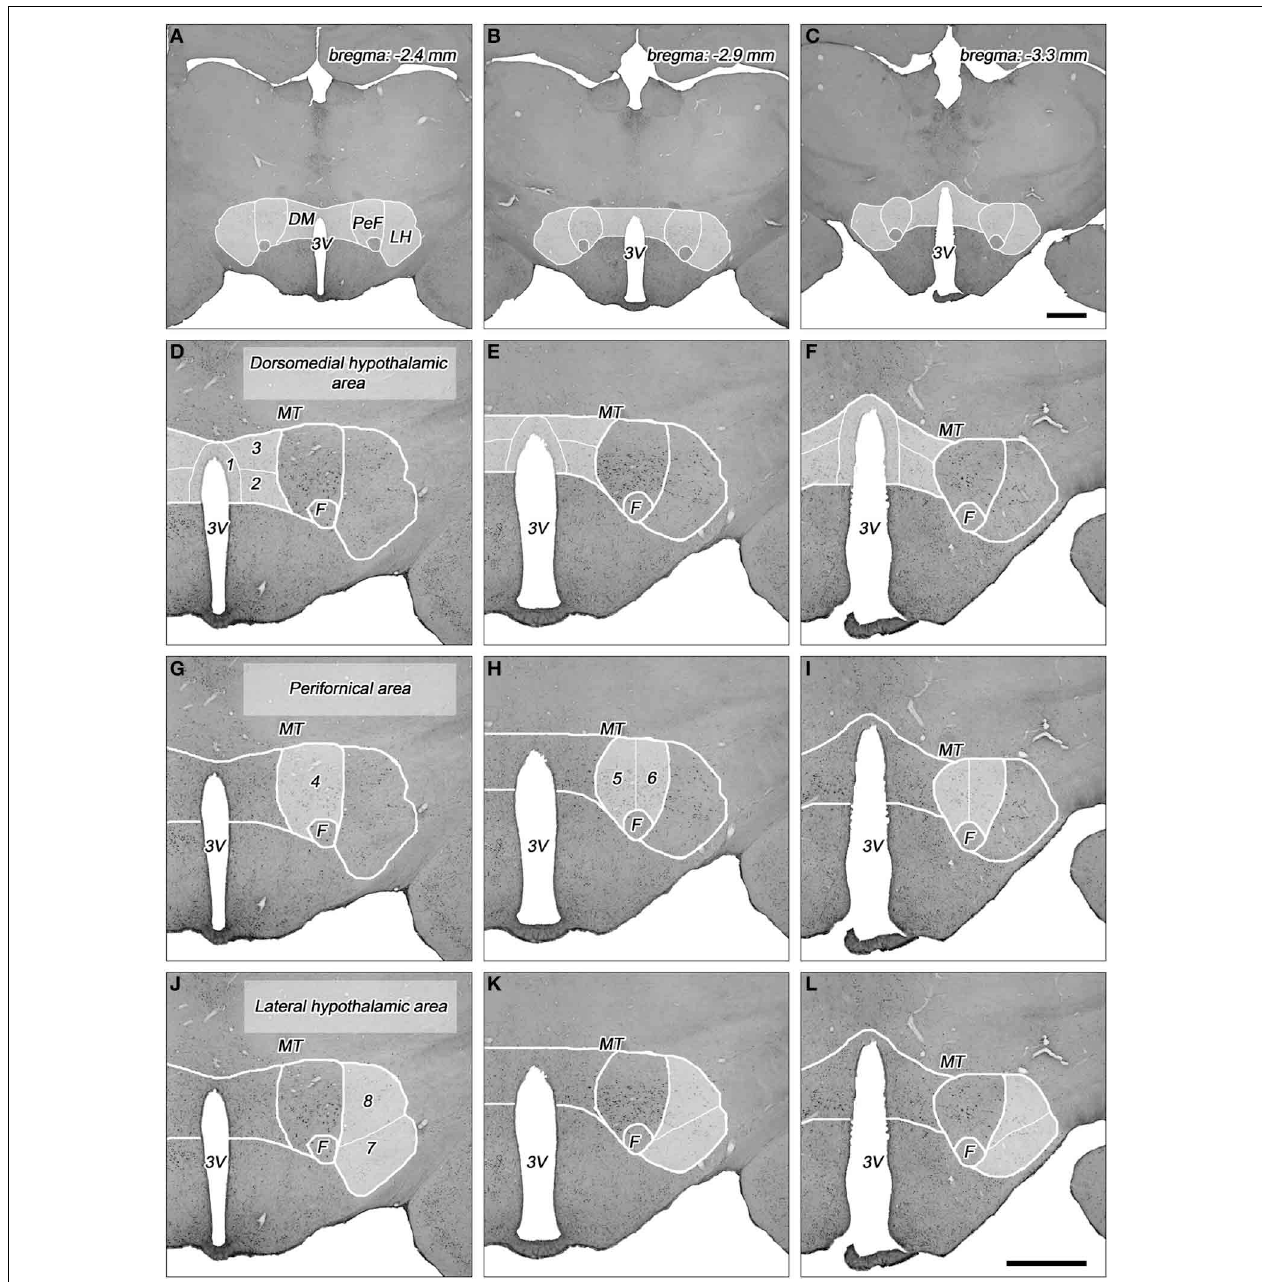
FIGURE 1 | Topography of the areas and their subdivisions in the dorsolateral hypothalamus. (A–C) Cross-sectional profile of the dorsolateral hypothalamus (DLH) in three coronal sections at various levels caudal to the bregma (indicated on the right top). Higher magnifications of DLH of (A) , (B) , and (C) are shown in panels (D,G,J) , (E,H,K) , and (F,I,L) , respectively. (D–L) The subdivisions of the dorsomedial hypothalamic (D–F) , perifornical (G–I) , and lateral hypothalamic areas (J–L) are numbered and indicated with white